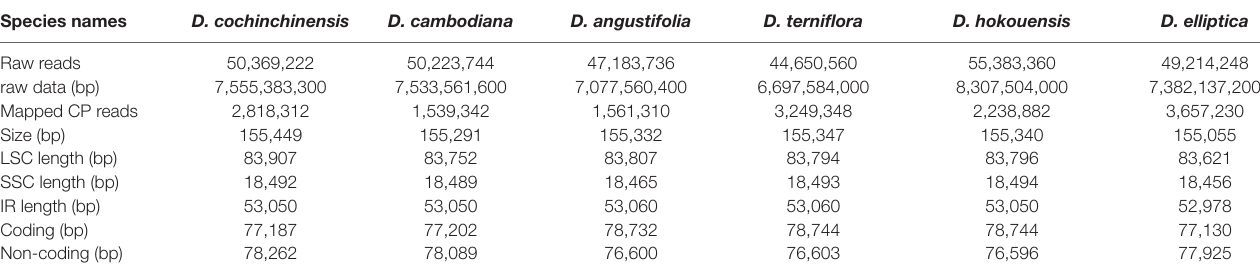
TaBLe 1 | Summary statistics for assembly of the six complete chloroplast (CP) genomes of Dracaena species. Species